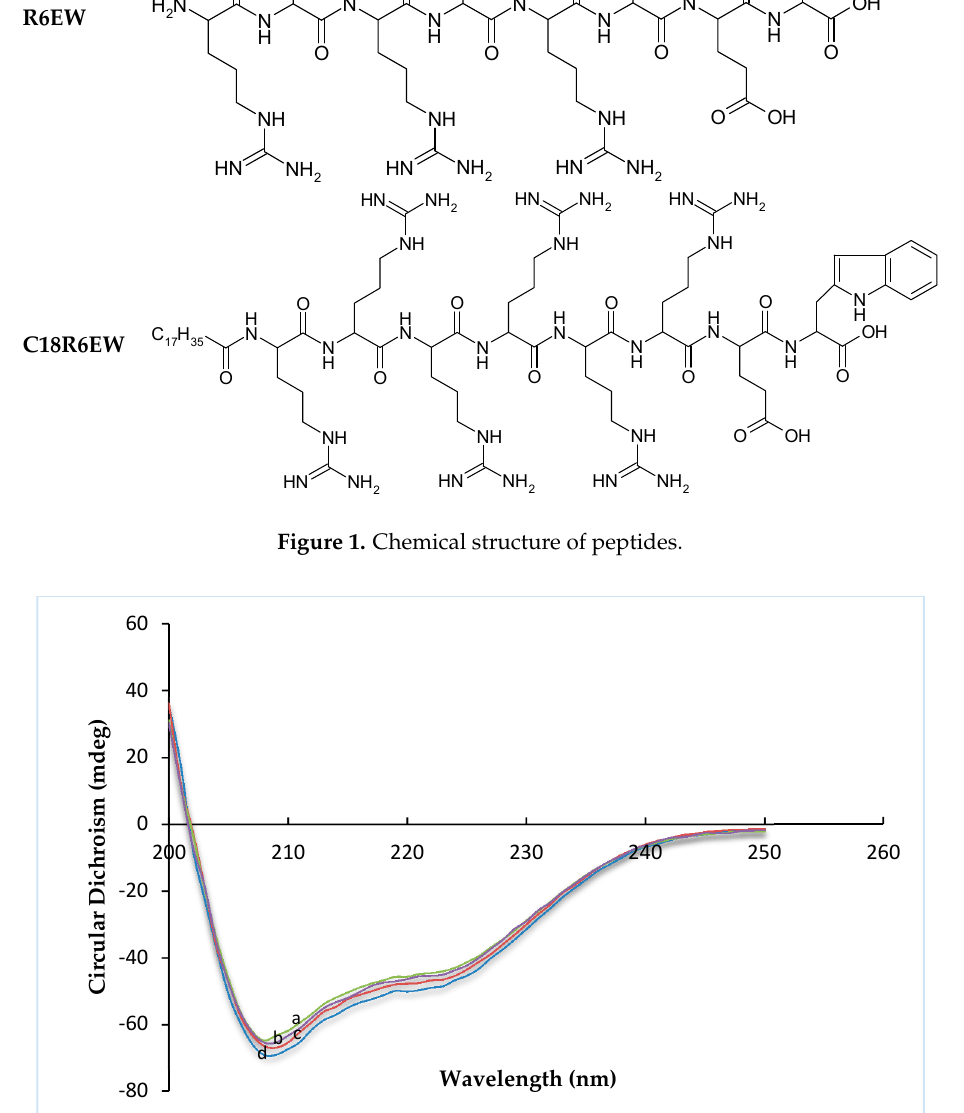
Figure 2. Far-UV CD spectra. a, insulin; b, R6EW-insulin; c, R8-insulin; d, SAR6EW-insulin.